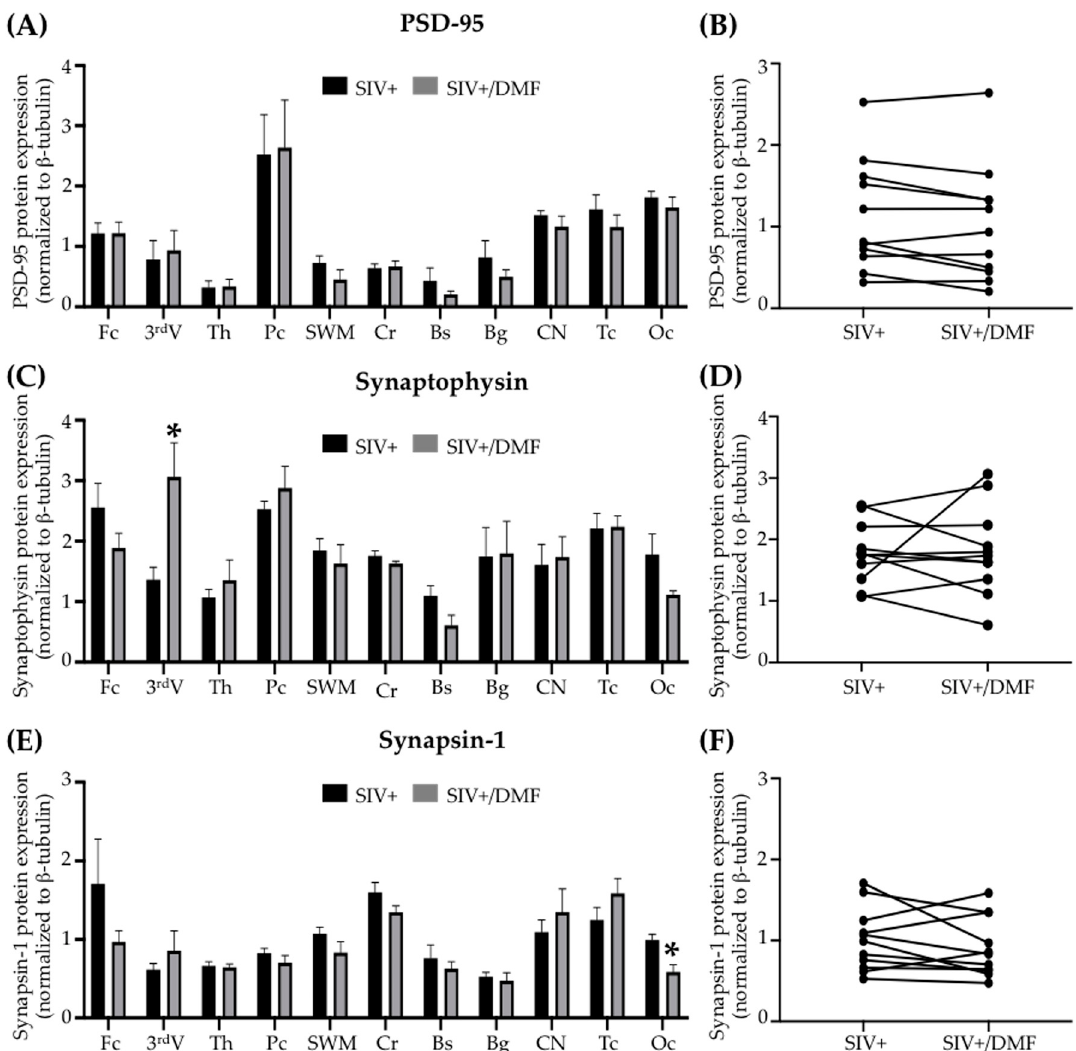
Figure 10. DMF treatment was associated with limited regional changes in expression of the synaptic proteins synaptophysin and synapsin I, but not PSD-95, in the brains of SIV-infected macaques. ( A,B ) No significant differences in PSD-95 (post-synaptic protein) expression were observed in individual regions or overall in the brains with DMF treatment. ( C ) A significant increase in synaptophysin (pre-synaptic protein) expression was observed in the third ventricle (Student’s unpaired t -test, * p < 0.05) but without a difference in the overall mean brain expression ( D ) with DMF treatment. ( E ) A significant decrease in synapsin 1 (pre-synaptic protein) expression was observed in the occipital cortex (Student’s unpaired t -test, * p < 0.05) but without a difference in the overall mean brain expression ( F ) with DMF treatment. Eleven brain regions from nine SIV-infected rhesus macaques (4 untreated animals and 5 DMF-treated (90 mg total DMF daily)) were analyzed using Western blotting. In the right panels, each dot represents the mean expression of one brain region from all animals in the group. Fc: frontal cortex, 3 rd V: third ventricle, Th: thalamus, Pc: parietal cortex, SWM: subcortical white matter, Cr: cerebellum, Bs: brainstem, Bg: basal ganglia, CN: caudate nuclei, Tc: temporal cortex, Oc: occipital cortex. All values are expressed as mean ± SEM.